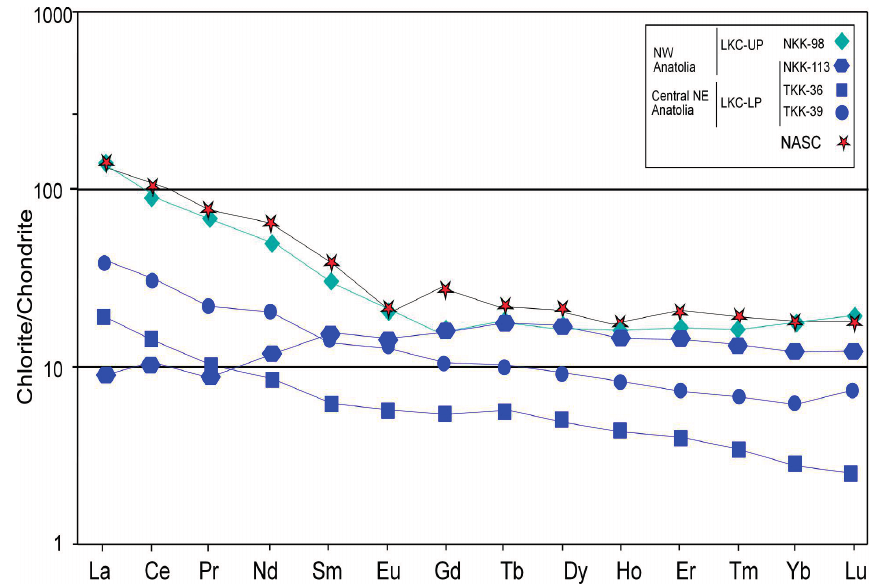
Figure 14. Chondrite-normalized rare earth element (REE) pattern of chlorite minerals in the Karakaya Complex units (Ho and Tm for NASC: Haskin et al. [52], other elements: Gromet et al. [50]; Chondrite: Sun and McDonough